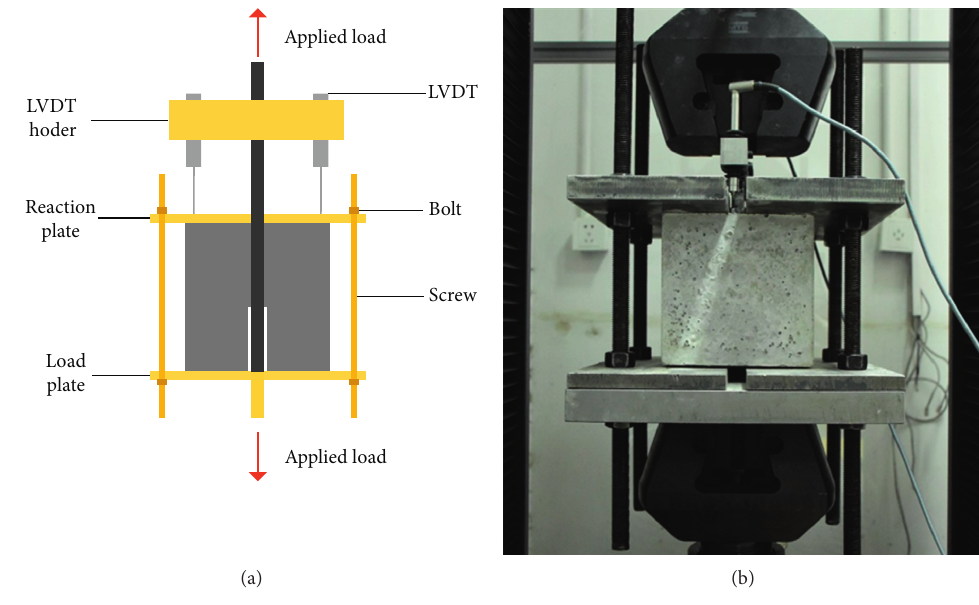
Figure 4: Setup and instrumentation of pullout testing. Table 4: Experimental results of all pullout